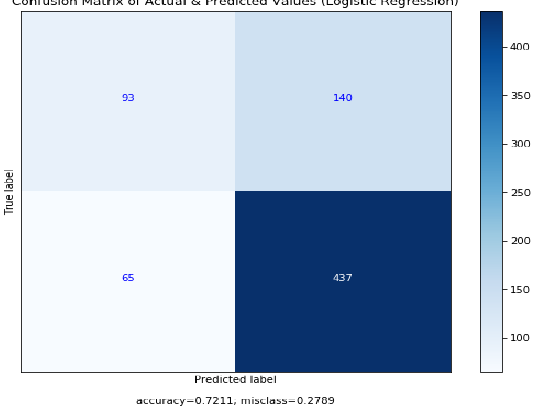
Figure 6. Logistic regression classifier CM